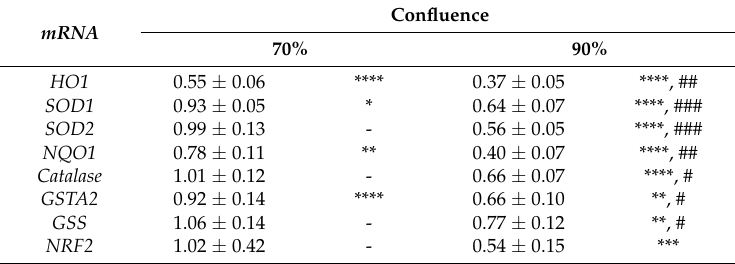
Table 2. Expression of AhR-target genes involved in the oxidative defense system under varying BeWo cell densities. mRNA